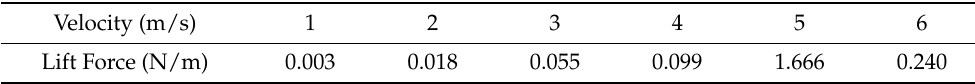
Table 3. Maximum amount of lift force at different velocities.